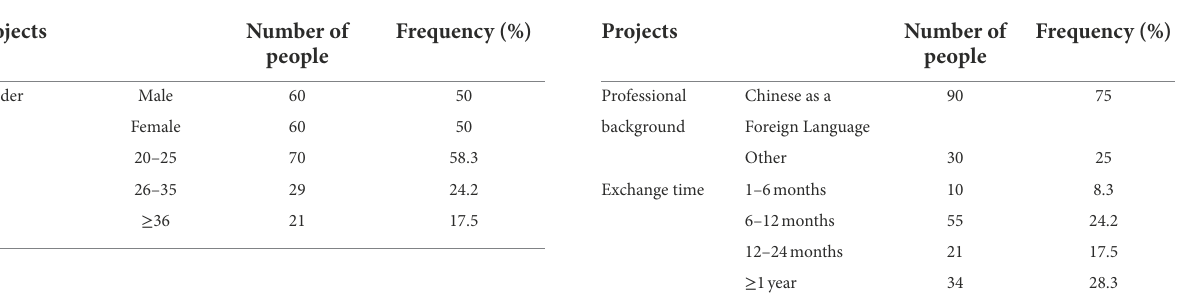
TABLE 1 Basic information concerning the survey subjects. TABLE 2 Personal experiences of respondents.